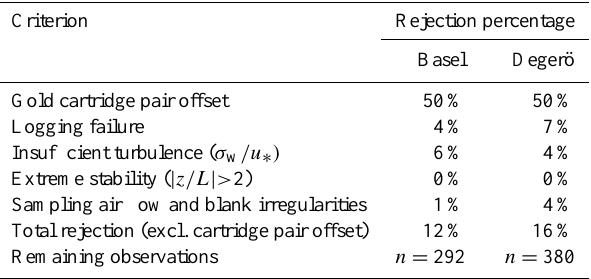
Table 1. Overview of rejection criteria for the evaluation of REA field measurements. Rejected amount of data (%) and remaining numbers of observations ( n ) are